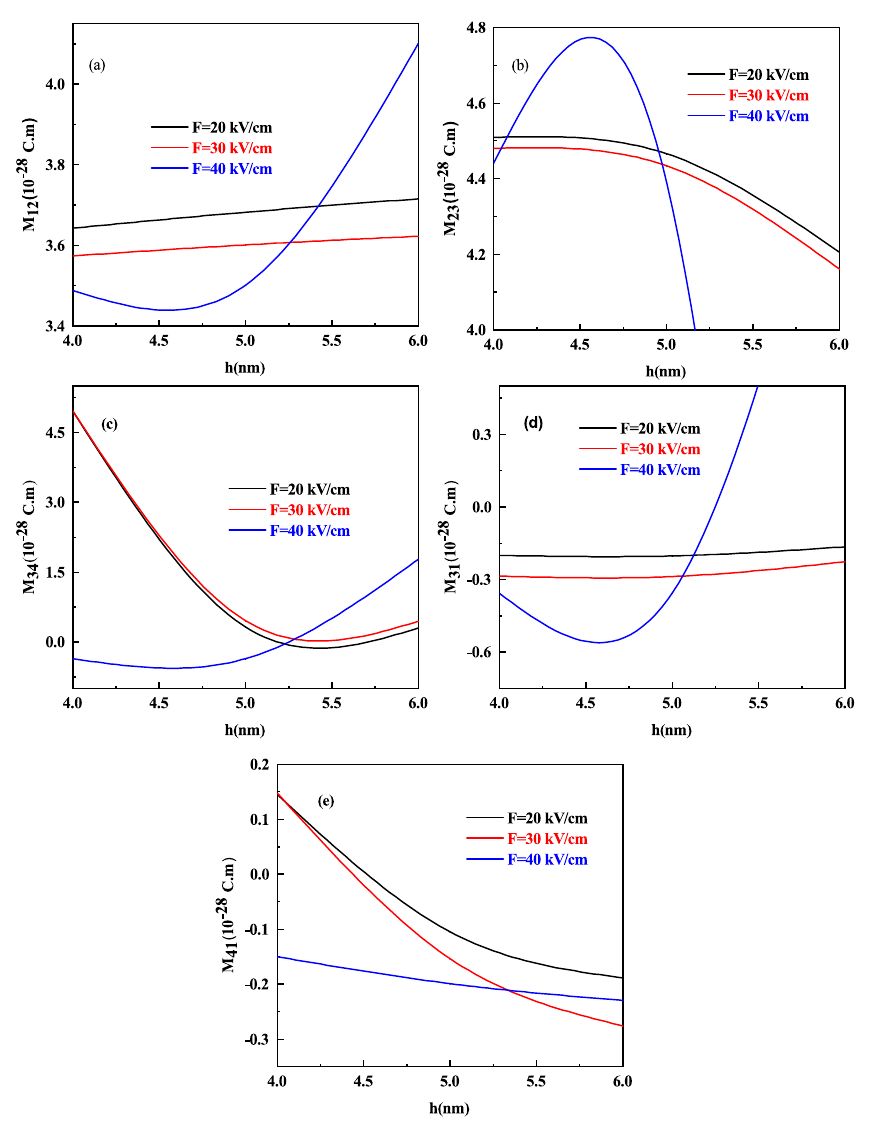
Figure 4. The DM elements ( a ) M 12 , ( b ) M 23 , ( c ) M 34 , ( d ) M 31 , and ( e ) M 41 as a function of oblate QD height h for R = 7 nm and for different values of lateral electric field F = 20,30 and 40 kV/cm